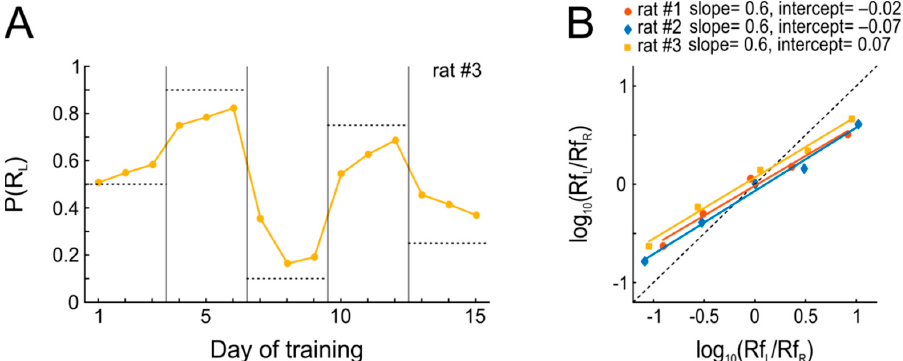
Figure 3. Rats quickly adapt when reinforcement contingencies change every three days. ( A ) Adaptation to new reward contingencies over five blocks. The panel depicts P(R L ) of an example animal over time. Horizontal dotted lines represent P(R L ) which would perfectly match P(Rf L ) within each block. Vertical lines separate blocks of conditions. ( B ) Matching behavior after three days of constant contingencies for all three animals. Regression lines were fitted to the data separately for each animal using Equation (2). Dotted black main diagonal represents the strict matching relation.